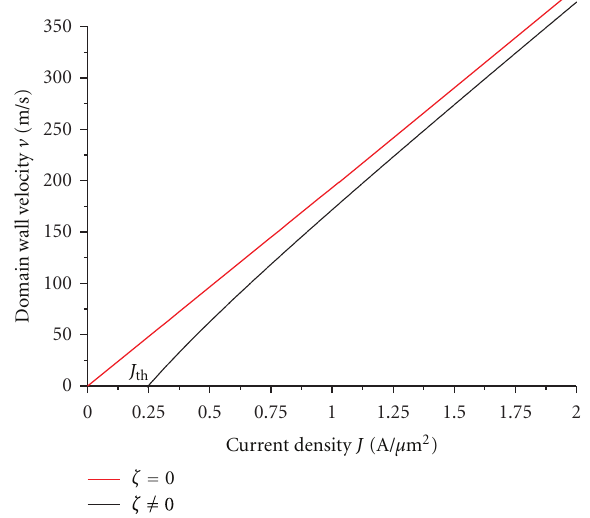
Figure 4: Current-driven DW velocities in the steady dynamic regime with and without the inclusion of the dry-friction dissipa- tion function in the mathematical model ( ζ / = 0 and ζ = 0, resp.). The limit of Walker has not been considered in this figure in order to better emphasize the nonlinear behavior of the DW velocity influenced by internal disorder, ζ / = 0, with respect to the case ζ = 0. Walker breakdown conditions, indeed, are not influenced by ζ